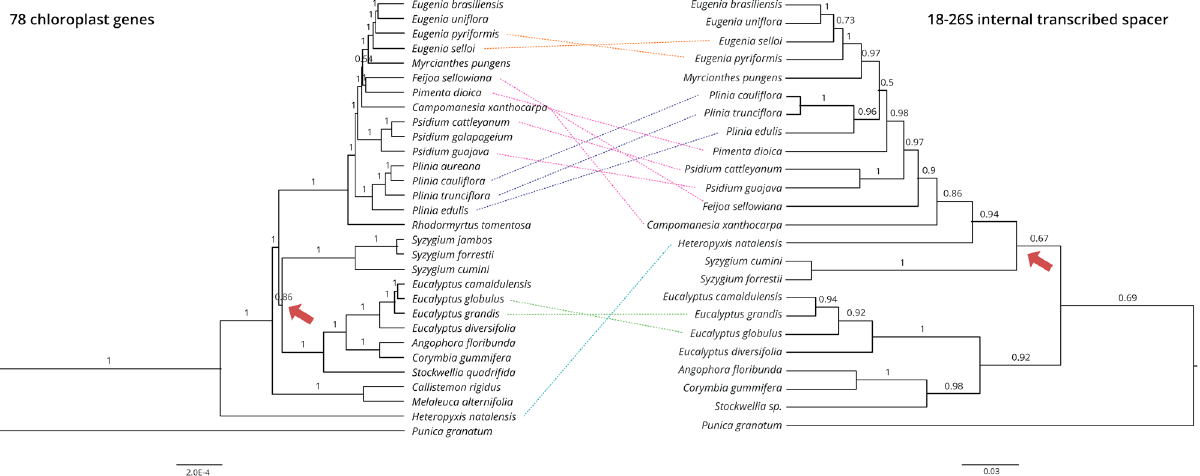
Figure 1 – Maximum clade-credibility phylogeny of Myrtaceae using 78 chloroplast protein-coding genes (left) and internal transcribed spacers (right). Posterior probabilities for each node are indicated and branch lengths are scaled according to the number of substitutions per site. Red arrows indicate the node grouping the tribe Syzygieae with either Eucalypteae or